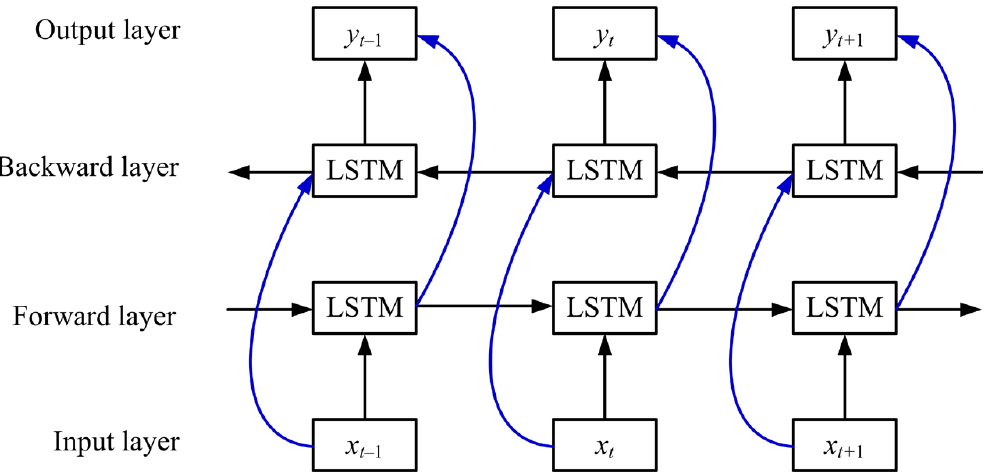
Figure 2. Structure of the bidirectional LSTM neural network.